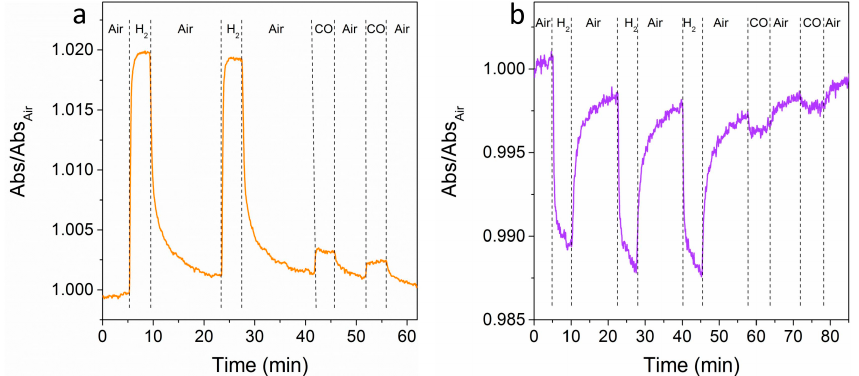
Figure 7. Dynamic tests after several air-gas-air cycles for: ( a ) NAT sample at 609 nm; ( b ) TAN sample at 580 nm.